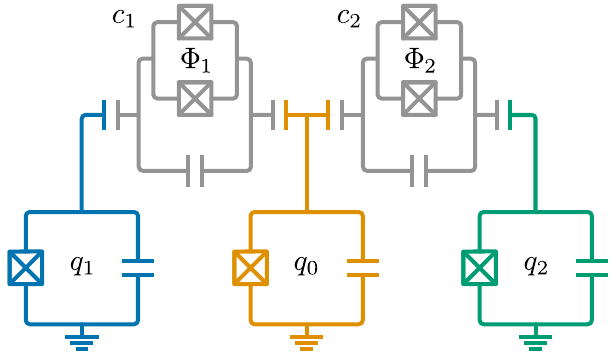
FIG. 9. Setup for implementing the CCZS gate with tunable couplers c 1 and c 2 connecting the qubits. The frequency of each coupler j is tuned by changing the magnetic flux (cid:15) j through the loop formed by the two Josephson junctions.